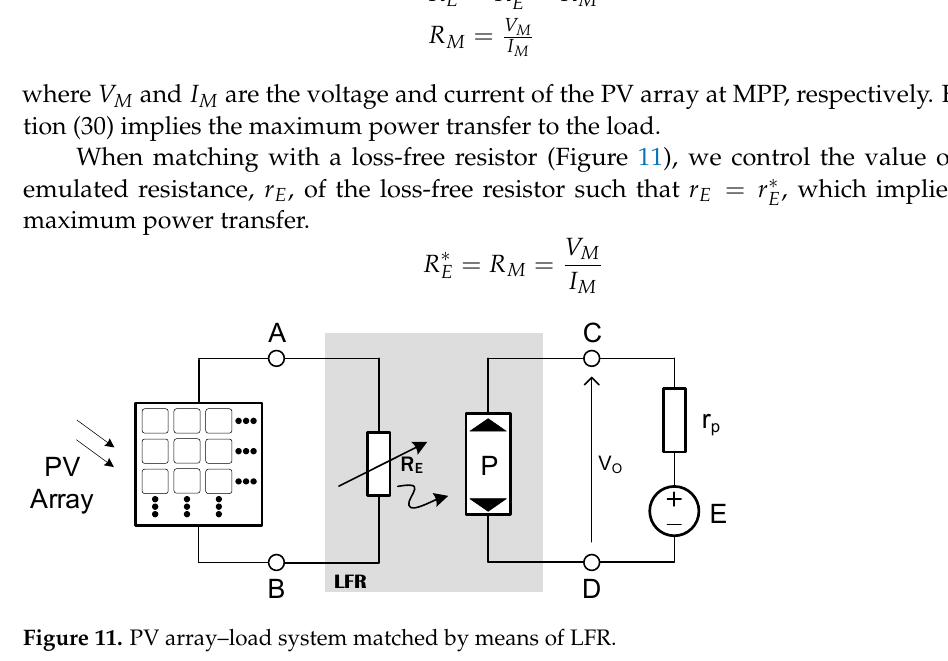
Figure 10. ( a ) The LFR model; ( b ) power source characteristic. Matching is achieved by controlling